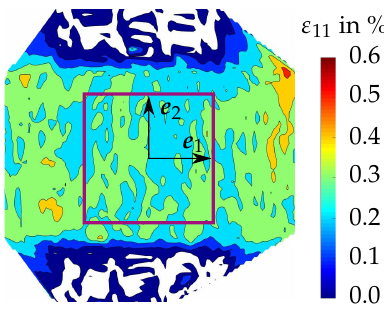
Figure 4. Image of the unreinforced cruciform specimen, thickness of the area of interest: 2